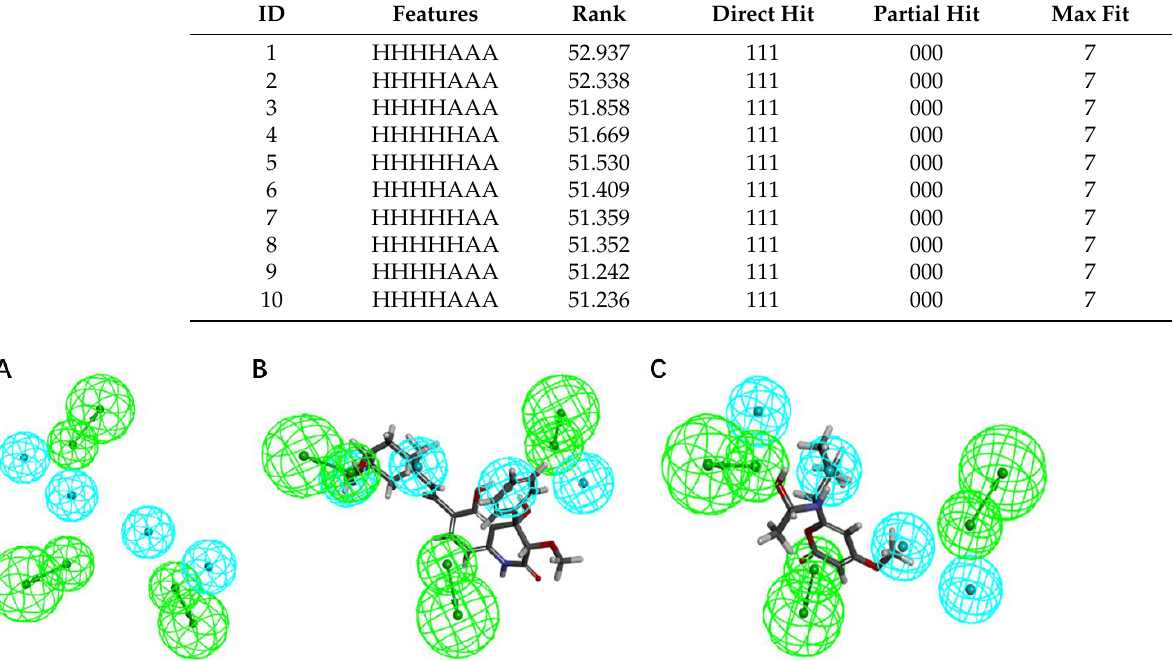
Figure 9. The pharmacophore model was generated based on the common features of the positive compounds and the matching status of the two candidate molecules with the model. ( A ) The common feature pharmacophore model; ( B ) the matching status of compound 44 and the model; ( C ) the matching status of compound 14 with the model.